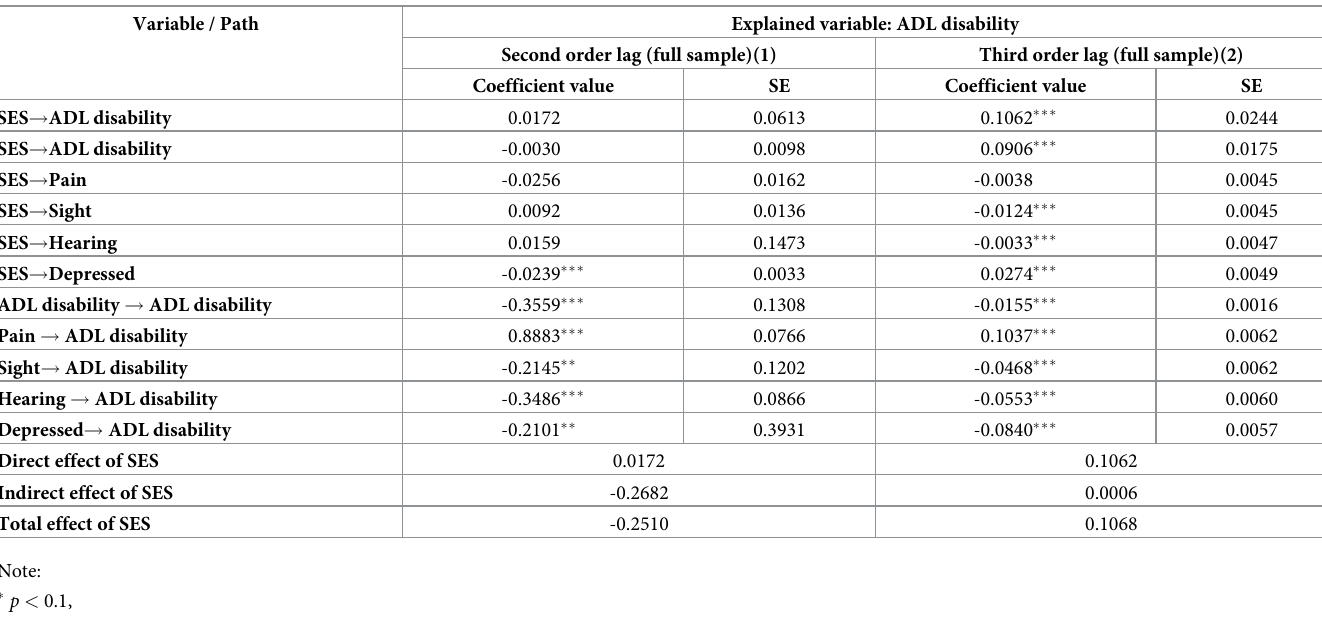
Table 7. The effect of SES lag on ADL disability in the older